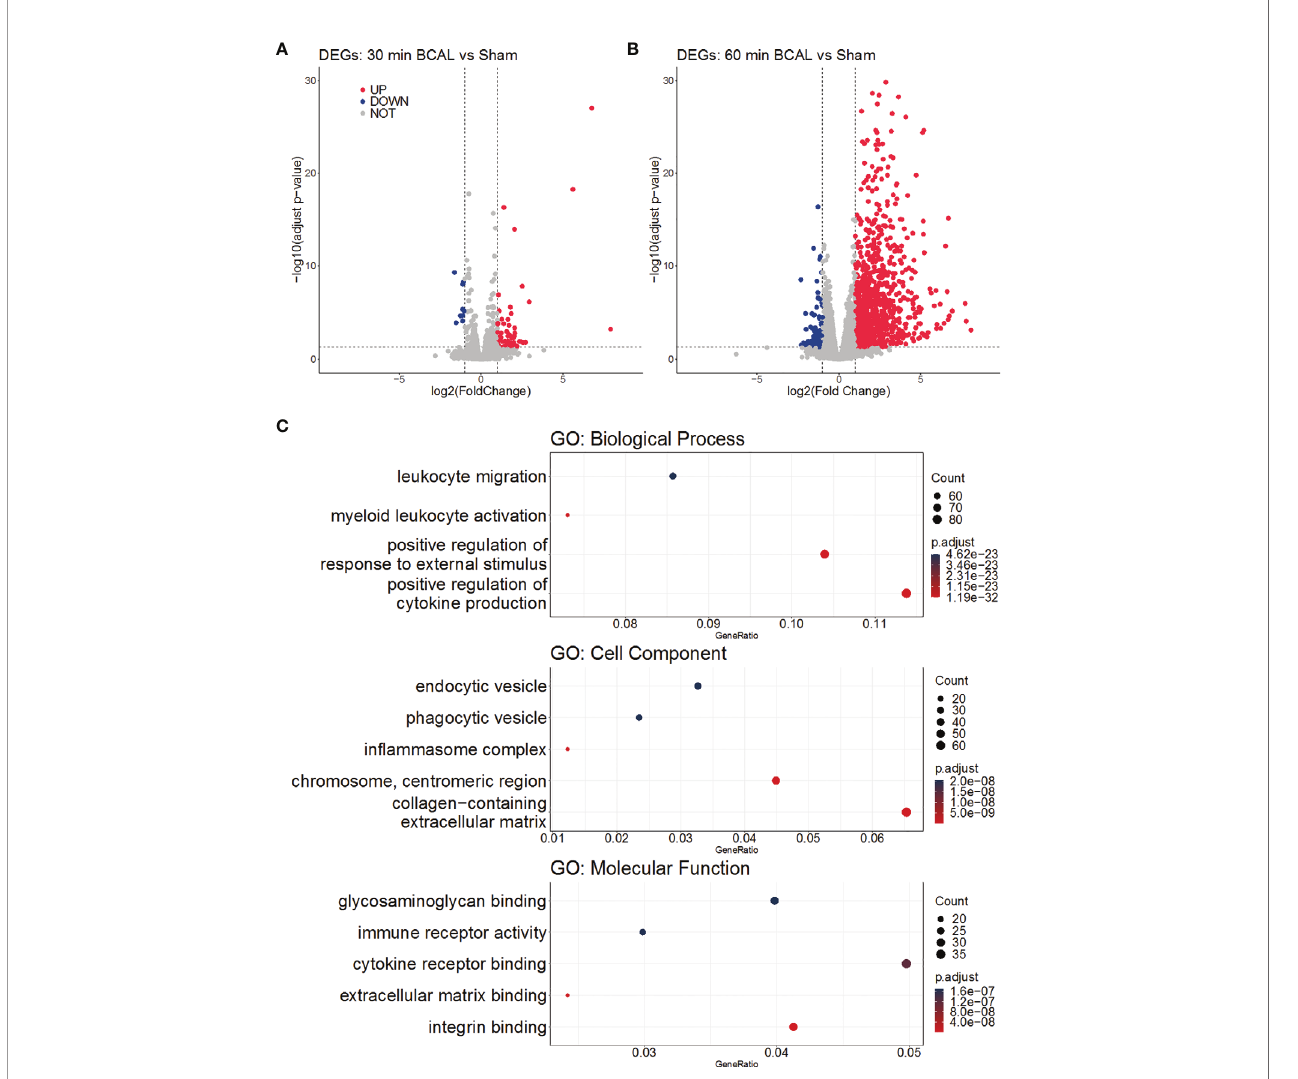
FIGURE 4 | Gene Ontology analysis of DEGs. (A, B) Volcano plots show the upregulation and downregulation of genes in the 30 min and 60 min BCAL groups, respectively. (C) GO enrichment of DEGs in 60 min BCAL. The top 5 terms of each GO aspect are displayed in order as: Biological Process, Cell Component, Molecular Function. The color indicates the signi fi cance of the term, and the size of the ball indicates the Gene Ratio in the